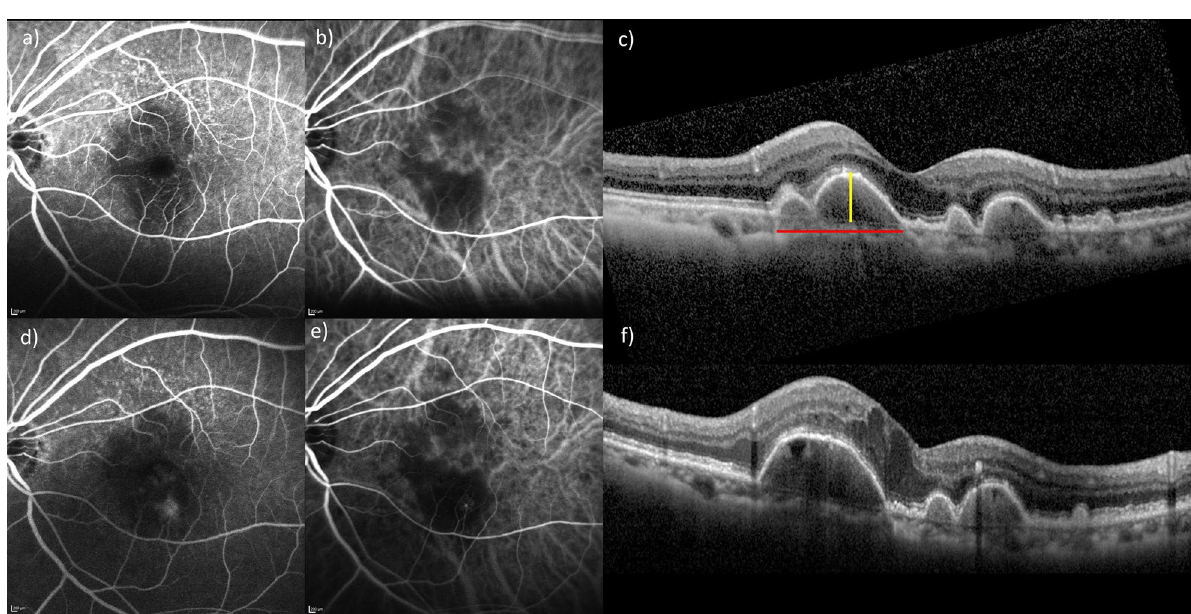
Figure 3. Drusenoid PED in the left eye of an 84-year-female. ( a ) Fluorescein angiography (FA) showed numerous hyperfluorescence in the region superior to the macula. ( b ) Indocyanine green angiography (ICGA) showed no evidence of macular neovascularization. ( c ) Baseline horizontal OCT scan showed that the drusenoid PED width (red line) and height (yellow line) were 877 µm and 154 µm, respectively. ( d ) FA showed a hyperfluorescent spot on the region inferior to the macula. ( e ) On ICGA, a hot spot was observed on the point corresponding to a hyperfluorescent spot on the FA. ( f ) A horizontal OCT scan showed intraretinal fluid 21 months after the initial